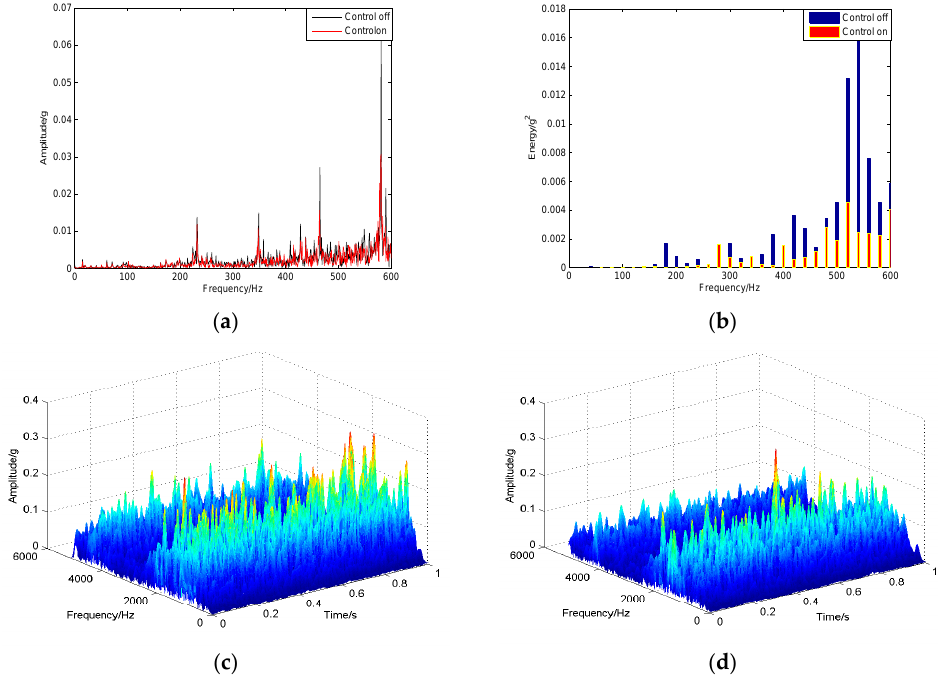
Figure 10. Experimental results of active vibration suppression in a milling process: ( a ) frequency spectrum ( b ) energy histogram ( c ) time-frequency waterfall diagram with control off ( d ) time-frequency waterfall diagram with control on.